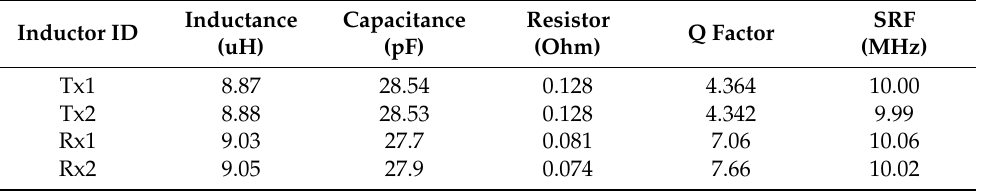
Figure A2. Comparison between theoretical result and the experiments. Two sets of PTU/PRU inductors are used in the experiments; we measured the parameters of the coils on the GW/Instek LCR-819 100 KHz LCR Meter and calculated the self-resonant frequency (SRF) for individual coils. The data are provided in Table A2. Table A2. Coil specifications used in the WPT experiments in this